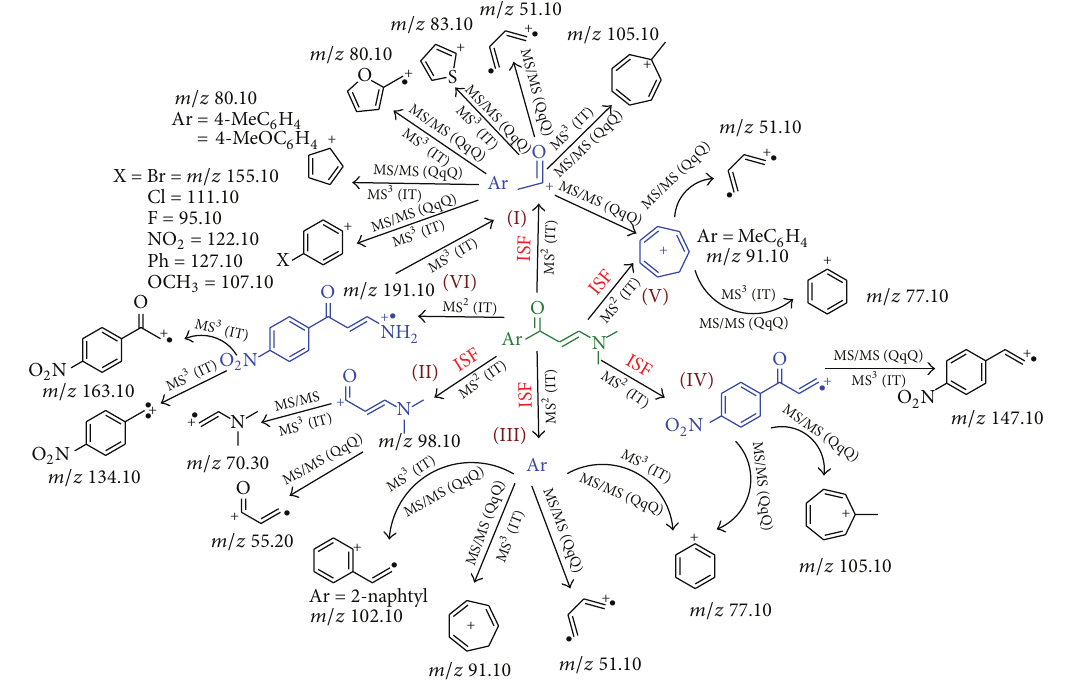
Scheme 2: Proposed fragmentation pattern of compounds 4a–j conducted with QqQ and IT.